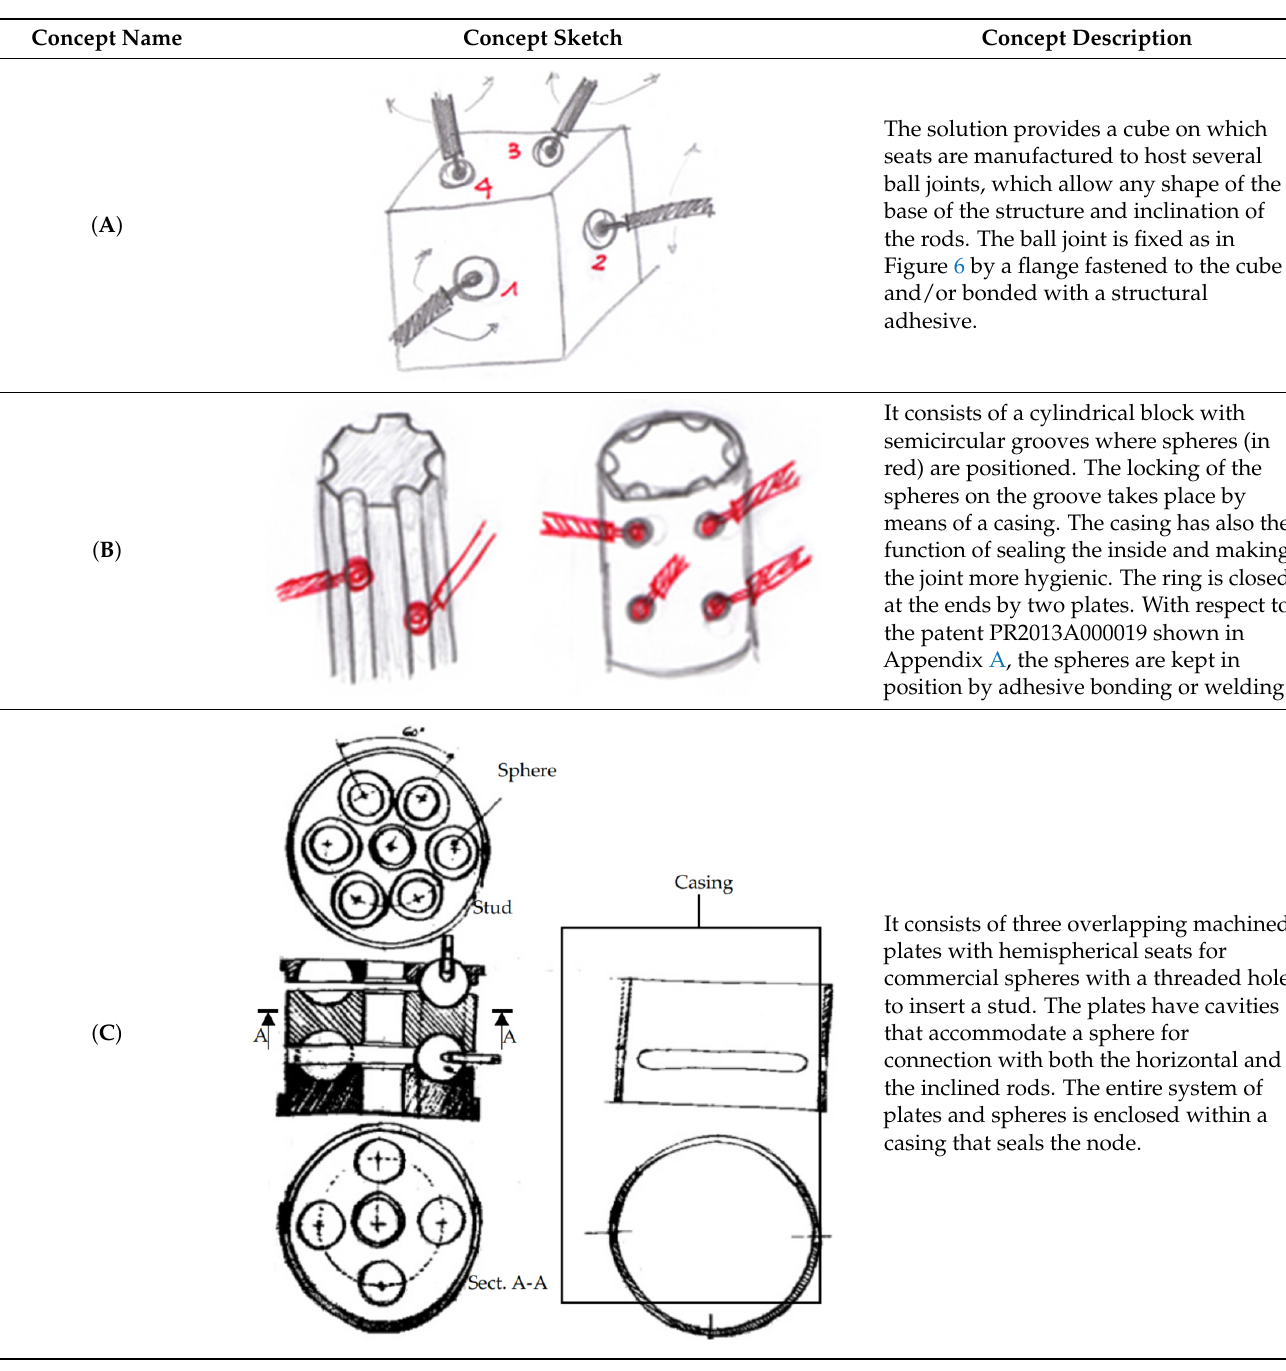
Table 4. Concepts devised starting with the patents and commercial elements referred to in Section